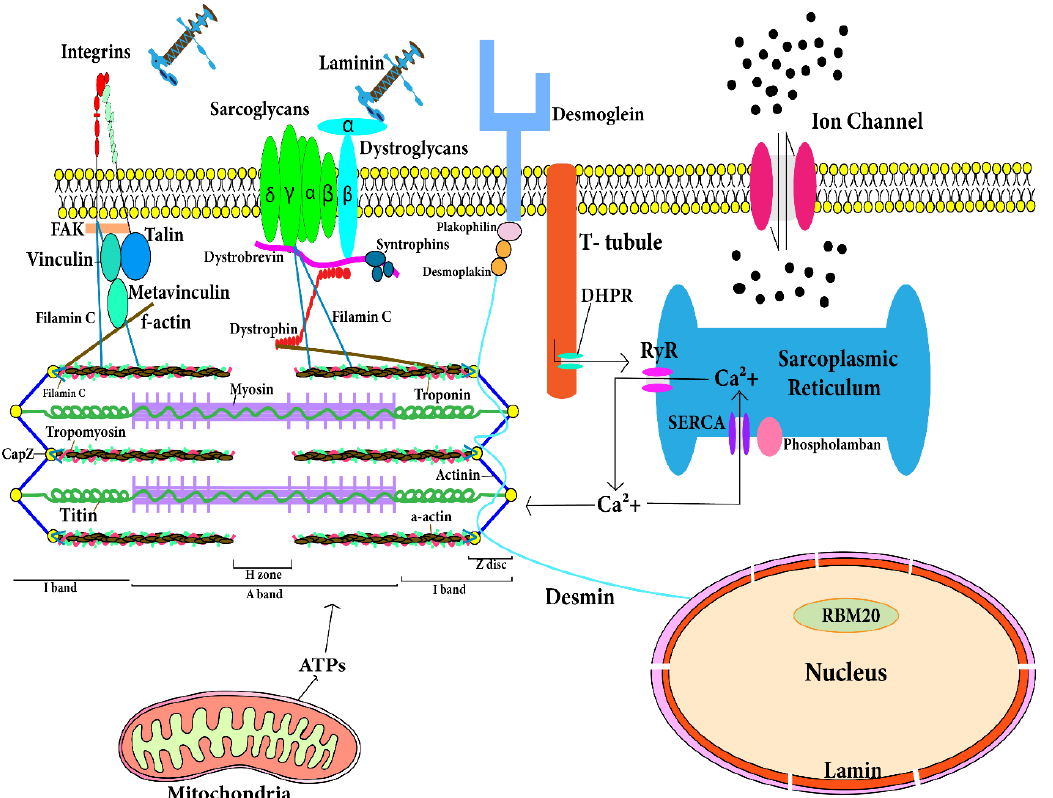
Figure 2. Location of proteins in cardiomyocytes that are responsible for development of dilated cardiomyopathy. The figure depicts the spatial location of the cytosolic and sarcomeric proteins encoded by corresponding genes. Mutations in these genes contribute to development of dilated cardiomyopathy. The T-tubule has a large number of ion channels and transporters. T-tubule regulates the calcium concentration in cardiomyocytes and transmits the action potential into the cardiomyocyte. RyR (ryanodine receptor) in sarcoplasmic reticulum (SR) of cardiomyocyte interacts with T-tubule for action potential transmission and RyR is responsible for release of stored calcium from SR. Calcium and ATPs are utilized by sarcomere in contraction. After contraction, calcium released from sarcomere is stored in SR through SERCA. Sarcolemmal and cytoskeletal proteins maintain architecture and functions of cardiomyocytes. Mutation in any of these protein-encoding genes leads to dilated cardiomyopathy.